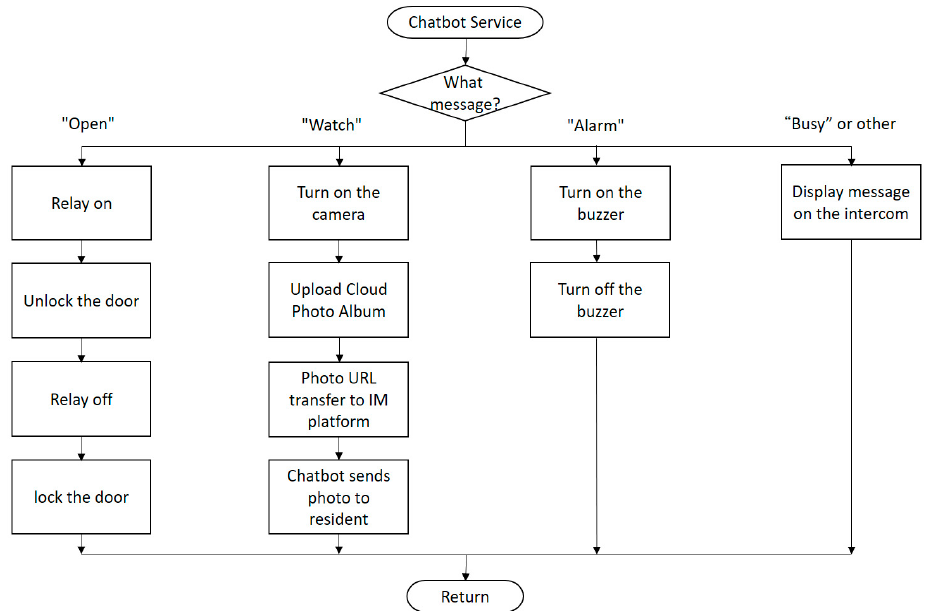
Figure 7. Function flow of the chatbot service.